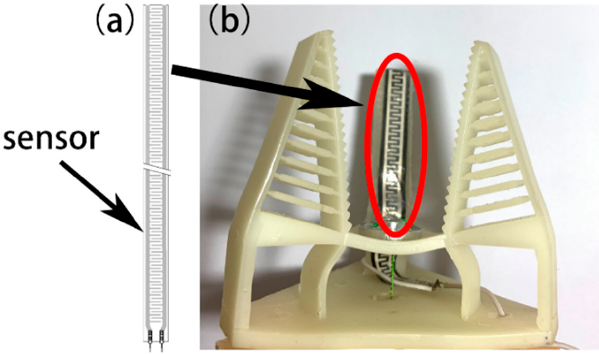
Figure 3. ( a ) Pressure film sensor. ( b ) Gripper with embedded sensor.